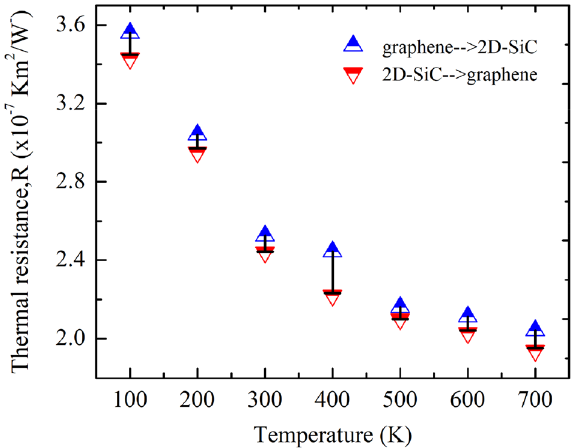
Figure 10. Interfacial thermal resistance variations in the heterobilayer for different temperatures from 100 to 700 K. Here, GRA- > SiC and SiC- > GRA refer to the direction of heat flow from graphene to SiC and SiC to graphene, respectively. There is a slight thermal rectification observed in the out-of-plane thermal conduction for different temperatures.